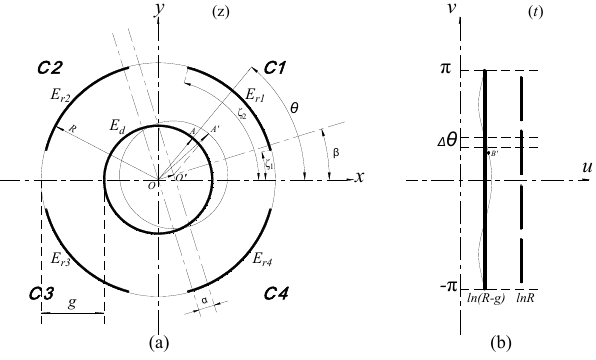
Figure 3. The calculation model of the radial error motions: ( a ) Boundary before transformation; ( b ) boundary after transformation.